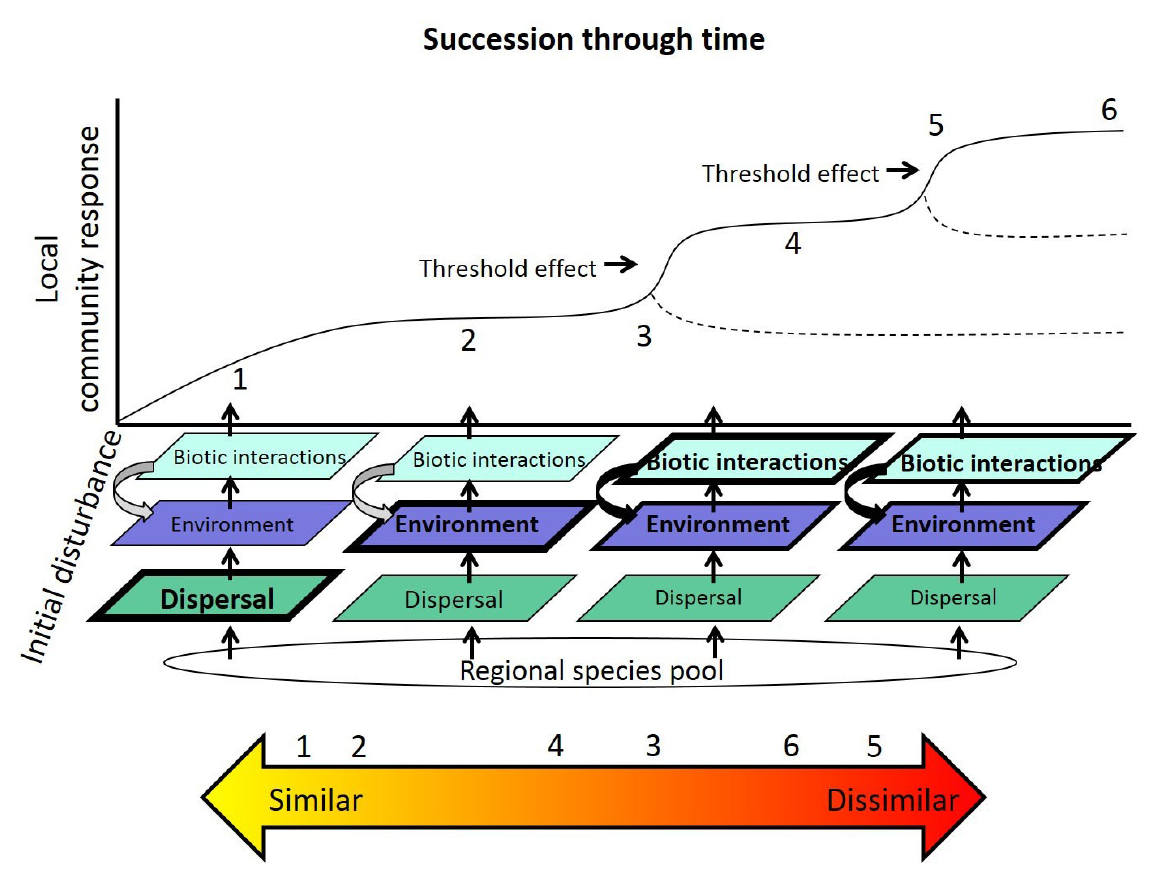
Figure 2. Integrated conceptual framework of community assembly processes over the course of succession after a disturbance. The regional species pool undergoes a filtering effect over the course of succession, where different filter effects are hypothesized to be more important at different time points (different size and bold of text indicates hypothesized relative strength). Threshold effects are driven by complex interactions and feedbacks that determine local community response (changes diversity, composition, and/or functional trait values) and shifts the community into an alternative state. Dotted lines represent alternative community states. Numbers represent changes in community composition or functional trait similarity across a gradient (yellow to orange arrow). Early in succession (1 and 2), communities start off more similar owing to dispersal and environmental filtering effects. At a threshold (3 and 5), the community becomes dissimilar in a short time span. As succession progresses, biotic interactions and environmental feedbacks make communities increasingly dissimilar compared to earlier in succession (4 and